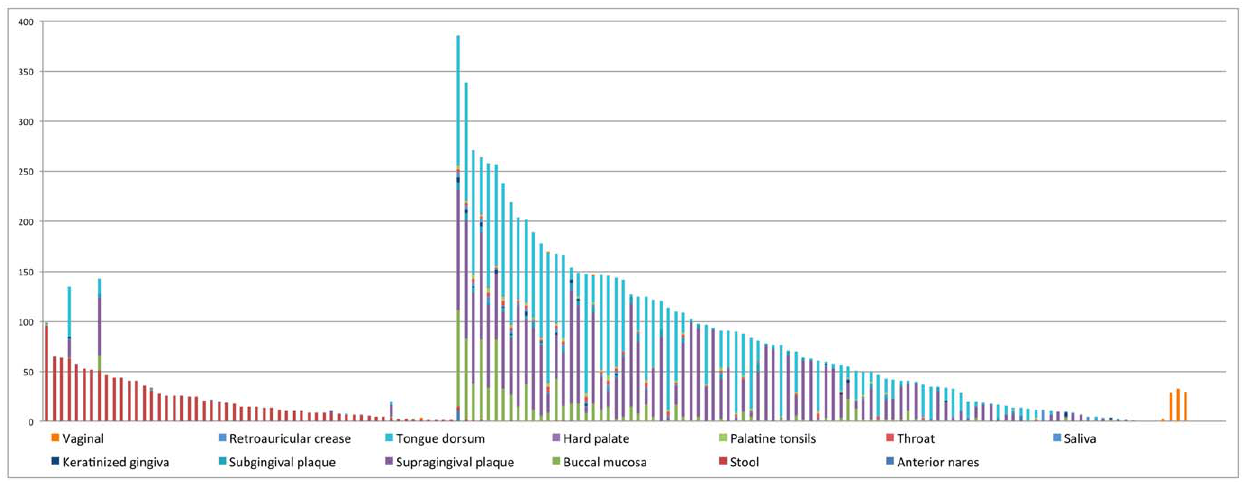
Figure 4. Distribution of CRISPRs across body sites. In this figure, the x-axis represents 150 CRISPRs and the y-axis represents the total number of samples in which instances of each CRISPR are found. Note that there are roughly one third as many stool samples as oral samples, probably explaining the apparently smaller number of CRISPRs in the gut microbiome. See Table S3 for details of the distribution of CRISPRs across body sites.